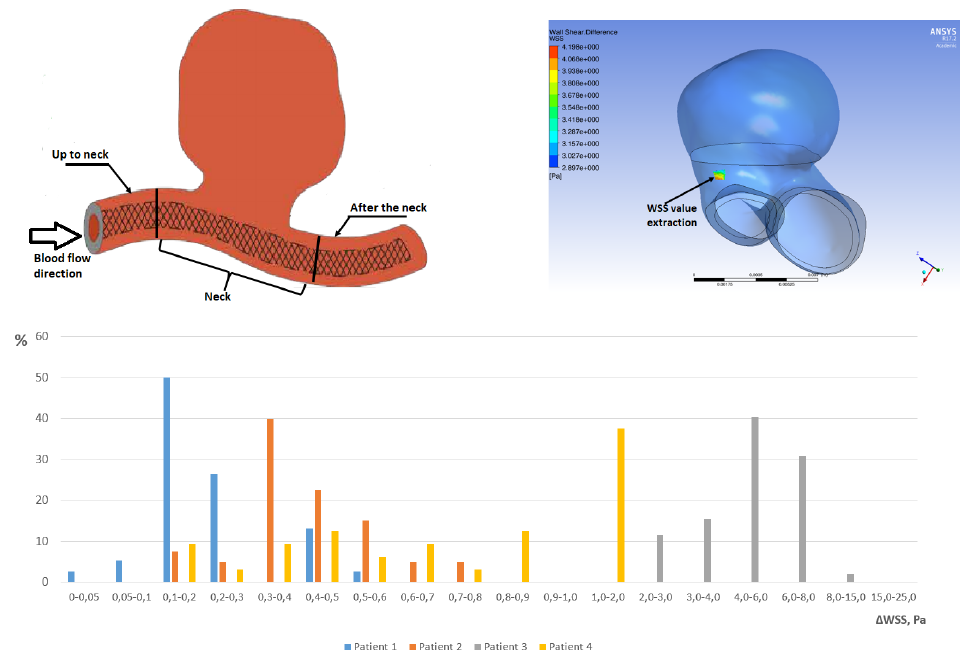
Figure 10. Analysis of ∆ WSS distribution over all mesh cells, located at the stent surface in the “after the neck” compartment (as it is shown). Horizontal axis corresponds to ∆ WSS values interval, vertical axis means the percent of mesh cells having ∆ WSS value in the corresponding interval. In all cases the quantities was presented at the time point t 2 (Other time points were also analysed and no sufficient differences were